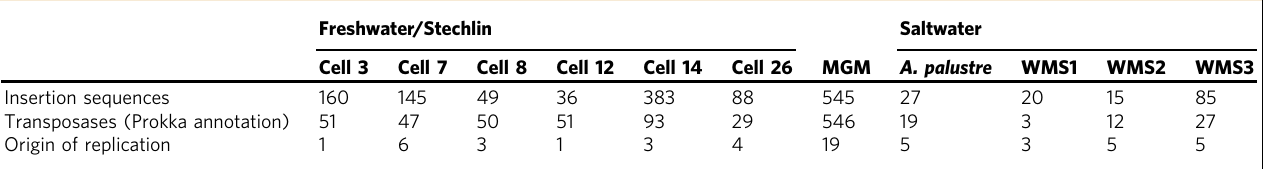
Table 1 Abundance of various genetic elements in Achromatium genomes and